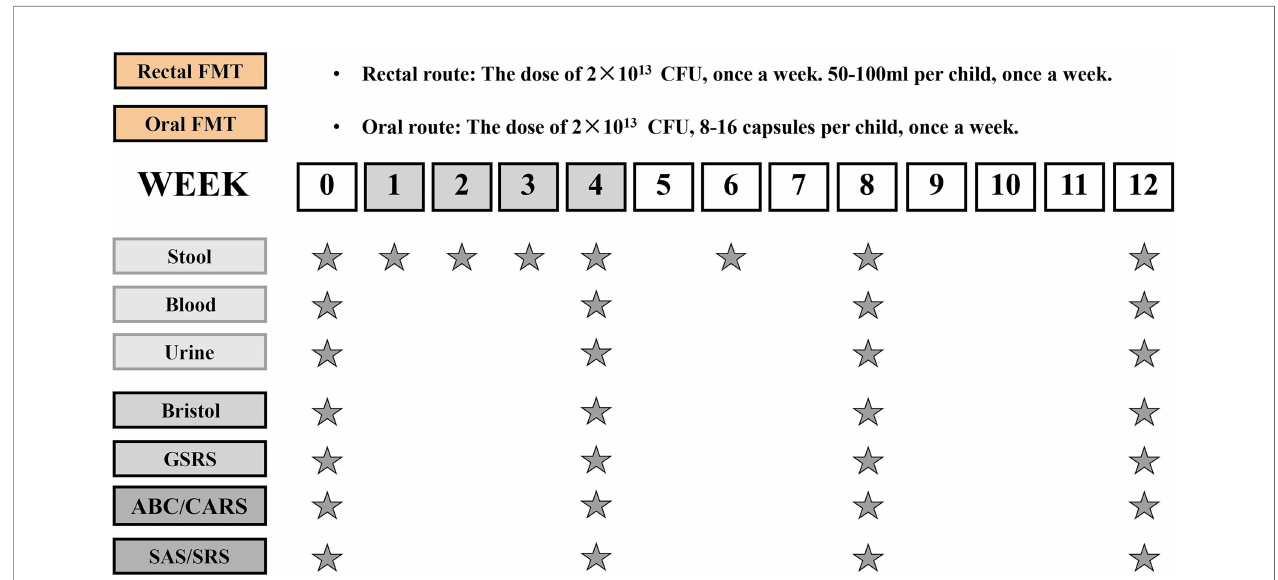
FIGURE 1 | Study design timeline. The trial consisted of a 4-week period of FMT and an 8-week follow-up observation period after the end of treatment. The time schedule of sample collection and GI/behavioral